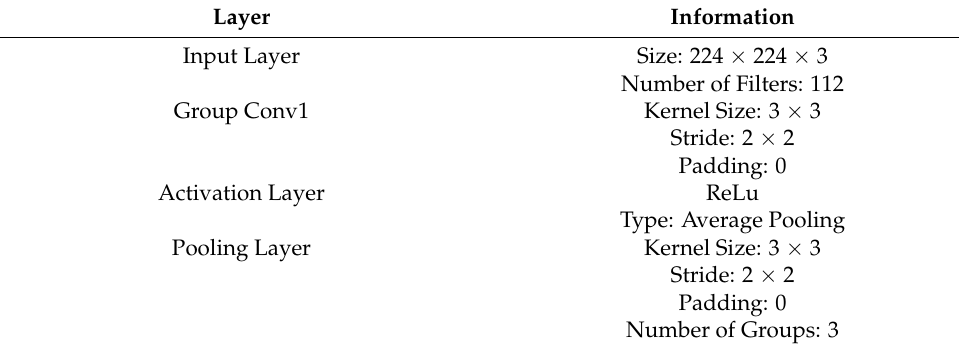
Figure 5. Atrophic Gastritis ShuffleNet structure. Table 2. Structure summaries for Atrophic Gastritis ShuffleNet.